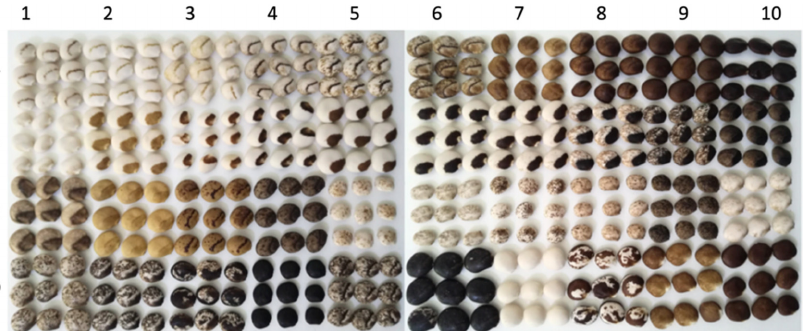
Figure 1. Common patterns of Lupinus mutabilis (tarwi) seed coat: eyebrow (A1–A10, C3 and D5); crescent (B1–C2 and C4); spotted (C5, C7 and C9); moustache (C6, C8, C10, D1 and D2); marbled (D3 and D8). Variants: A1 (white with brown eyebrow), A2 (white with cream brown eyebrow); A3 (white with brown spotted and cream brown eyebrow); A4–A6 (white with brown spotted and dark brown eyebrow); A7 (light brown with brown eyebrow); A8 and A9 (brown with dark brown eyebrow); A10 (dark brown with dark brown eyebrow); B1 (white with grey crescent); B2 (white with cream brown crescent), B3–B5 (white with brown crescent), B6 (white with black crescent); B7 (white with dark brown crescent); B8 and B9 (white with brown spotted and black crescent); B10 (grey with black eyebrow); C1 (light grey with dark grey crescent); C2 (cream with cream crescent); C3 (cream with spotted and brown eyebrow); C4 (grey with spotted and dark grey crescent); C5 and C7 (white with brown spotted); C9 (white with grey spotted); C6, C10 and D1 (white with grey spotted and grey moustache), D2 (white with grey spotted and black moustache); C8 (white with brown spotted and moustache), C9 (grey spotted); D3 (white with black marbled); D4 (black); D5 (white with grey spotted and black eyebrow); D6 (combination black marbled and black colour); D7 (white); D8 (white with brown marbled); D9 (light brown); D10 (brown) (according to IBPGR